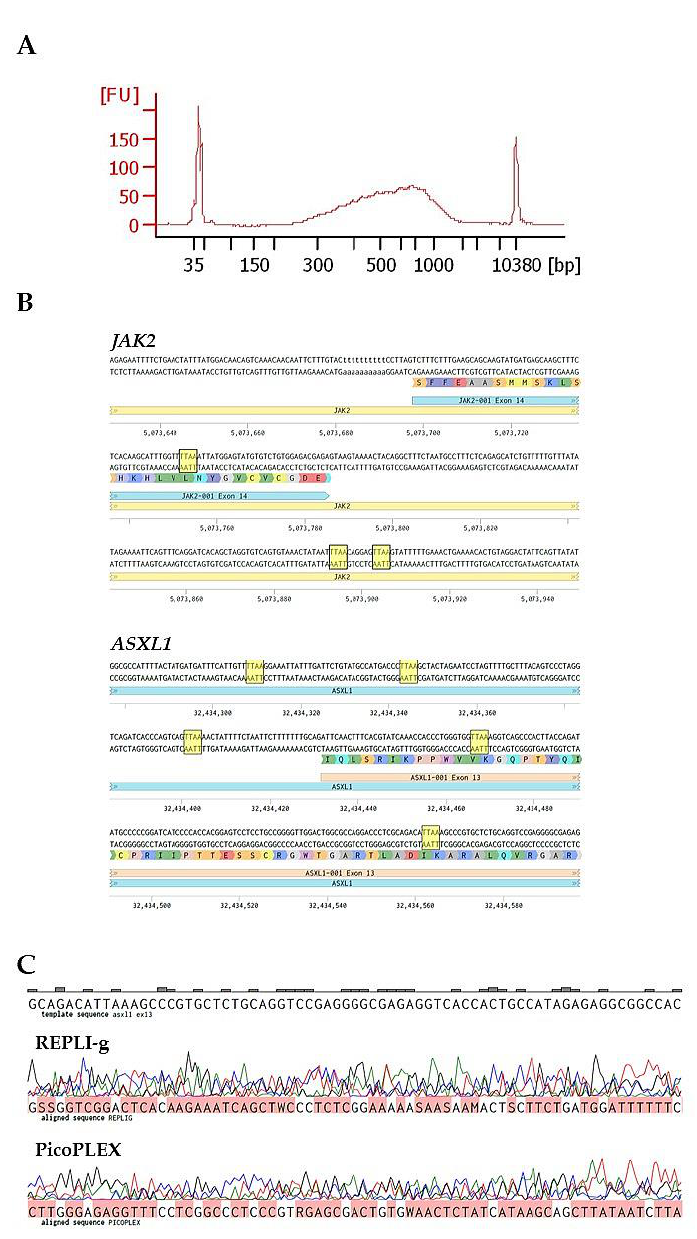
Figure 2. WGA kit’s efficiency on cells fixed overnight with 2% PFA. ( A ) Bioanalyzer profile of amplified DNA, obtained through Ampli1 WGA kit, coming from a single CD34+CD38- cell. ( B ) Cutting frequency of MseI enzyme, used for DNA fragmentation in Ampli1 single-cell WGA kit, in two representative regions of JAK2 and ASXL1 genes. 5’-TTAA-3’ restriction sites are highlighted in yellow. ( C ) Two representative sequences of ASXL1 gene deriving from CD34+CD38- cells ( n = 20) fixed with PFA 2% overnight. A single-cell genome was amplified with either RepliG or PicoPLEX WGA kit. Both sequences were unreadable highlighting the incompatibility between the kits and the fixation protocol.